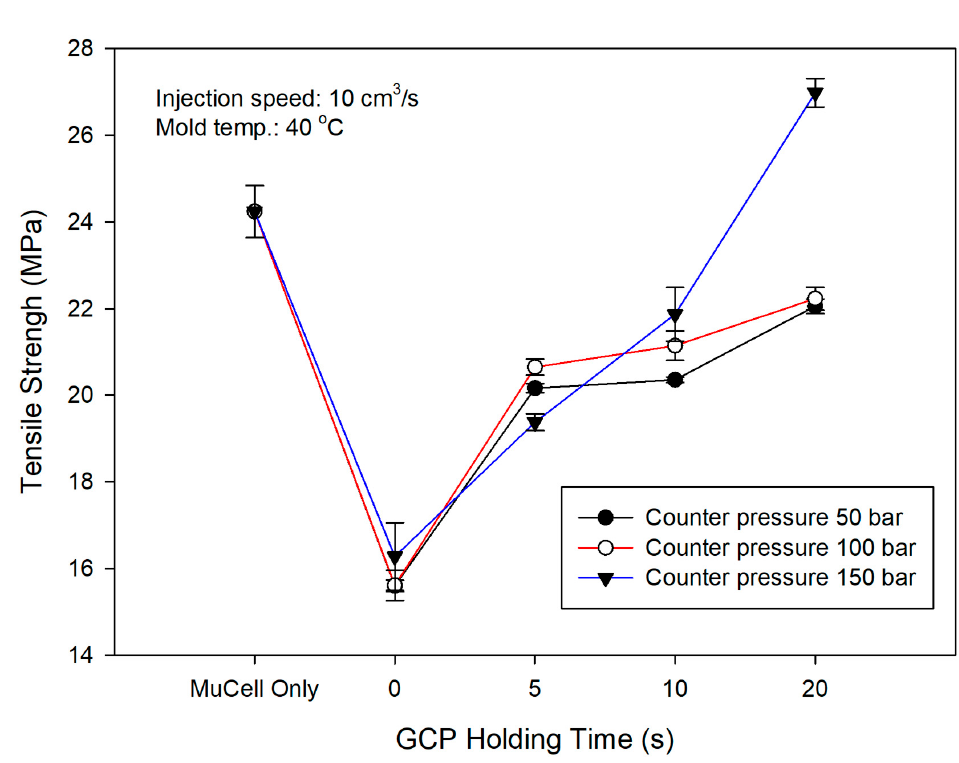
Figure 15. Tensile strength comparison of microcellular injection-molded PP with different GCPs and holding times.